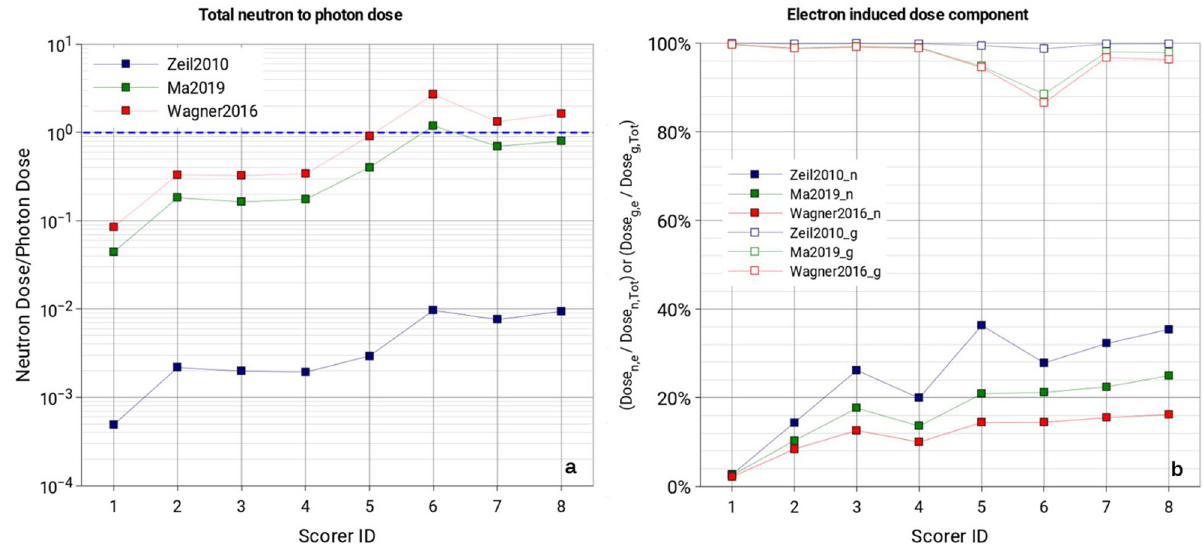
Figure 11. ( a ) Total neutron to total photon dose ratio (the blue dashed line lies at ratio = 1). ( b ) Electron- induced neutron dose fraction of the total neutron dose (full markers) and electron-induced photon dose fraction of the total photon dose (open markers). Values are displayed for all scored positions inside the LION cave (scorers 1–8). To guide the eye, data points have been linked using straight lines.